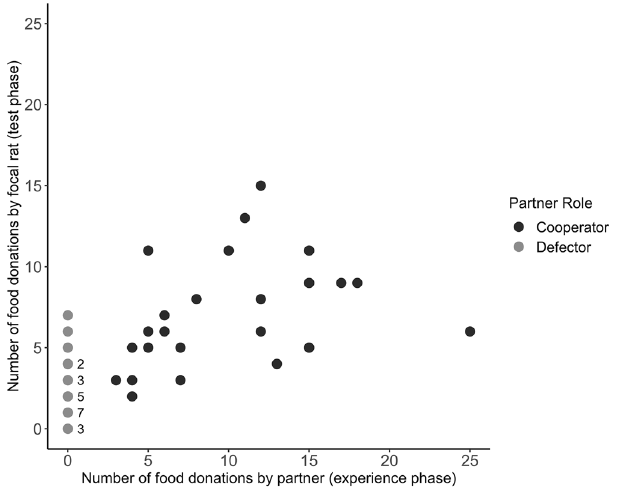
Figure 5. Total number of food rewards provided by focal rats to specific partners in relation to the number of food rewards previously received from them. Food donations exchanged between the focal individuals and their partners were positively correlated. For the statistical analysis, only the data from “cooperators” were considered. Numbers beside points denote the number of overlapping data points. Focal individuals donated more food to partners that had provided more food to them during the experience phase than to those that had been less